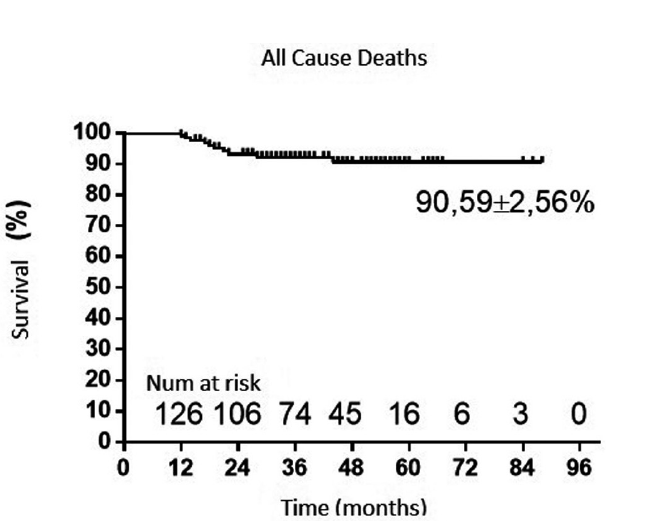
Fig. 1 - Kaplan-Meier survival curve after 88 months of aortic valve prosthetic implantation.